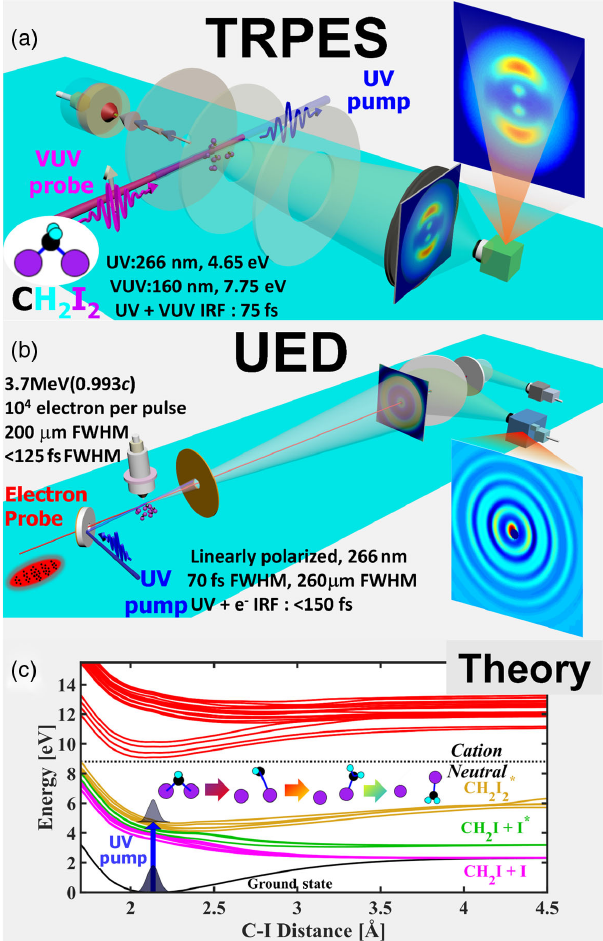
FIG. 1. Schematic diagrams illustrating the experimental meth- ods and calculations to follow the photoinduced excited-state dynamics of CH 2 I 2 . (a) A schematic diagram of the time-resolved photoelectron spectroscopy experiment. A cartoon of the CH 2 I 2 molecule is shown in the bottom-left corner. (b) A schematic diagram of the relativistic ultrafast electron diffraction experiment. Two cameras are responsible for recording images of scattered and unscattered electrons. (c) A cartoon of potential energy curves together with structural changes of CH 2 I 2 after UV excitation. A black dotted line separates the neutral and cation